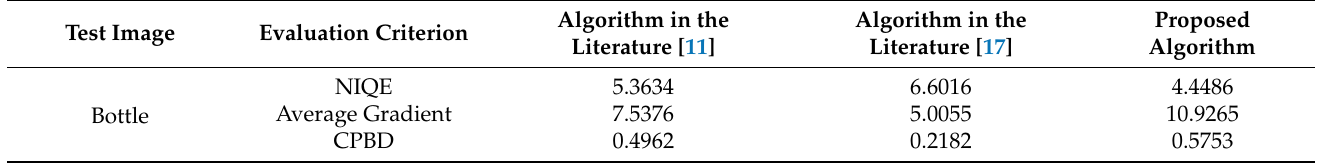
Table 8. Final results of the no. 1 experiment.